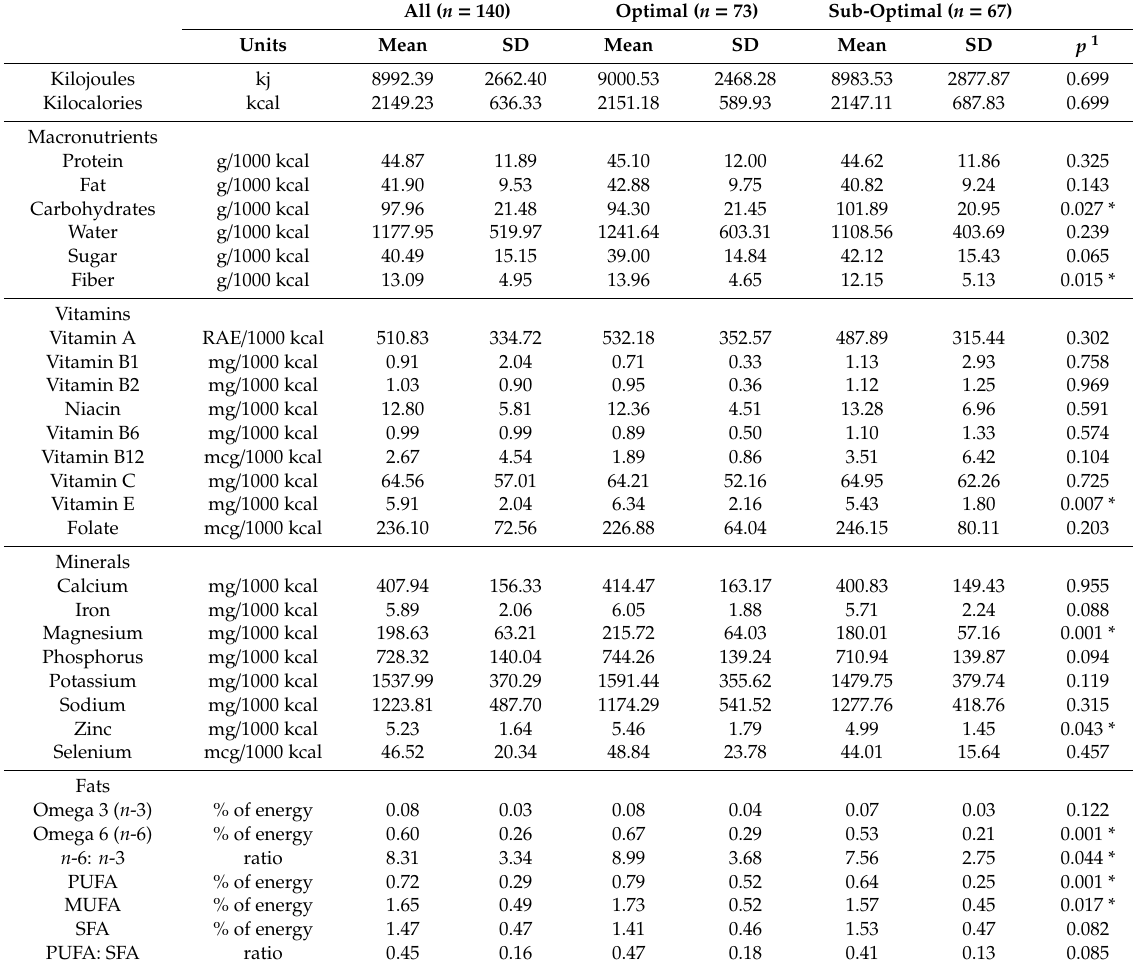
Table 2. Energy-adjusted nutrient intake derived from ASA24 recalls for all participants and by diet quality